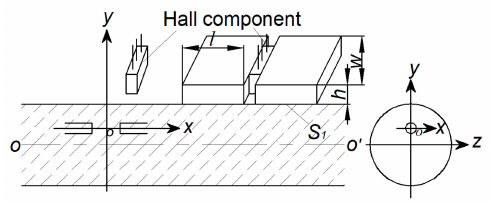
Figure 3. Schematic of magnetic concentrating